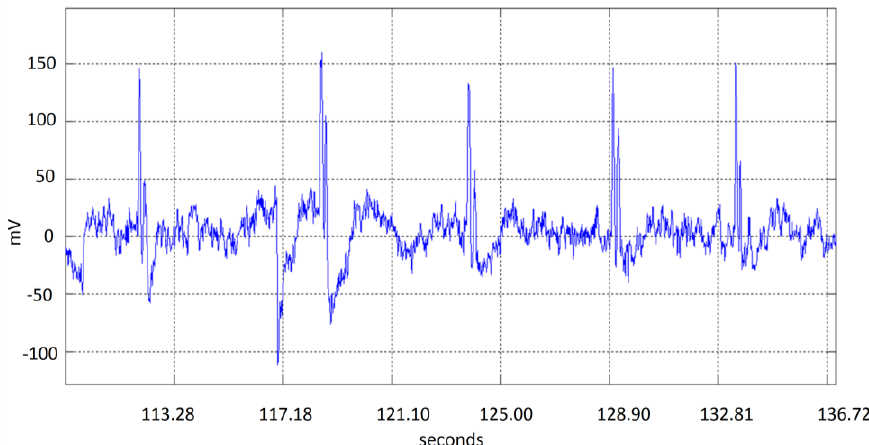
Figure 4. Head movement noise during double blinking events.